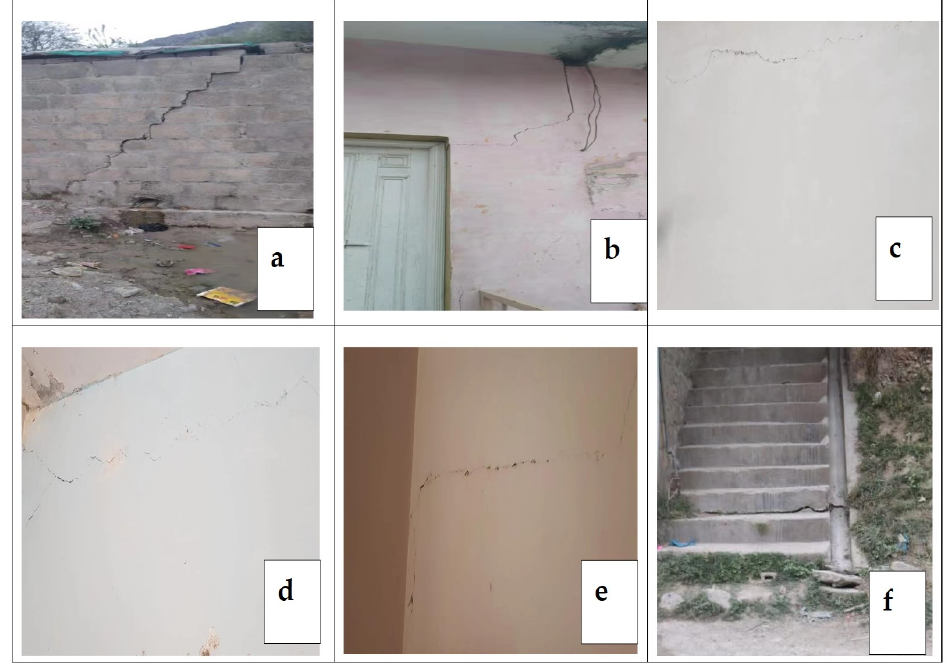
Figure 14. Cracks in the walls and stairs within the study area ( a – f